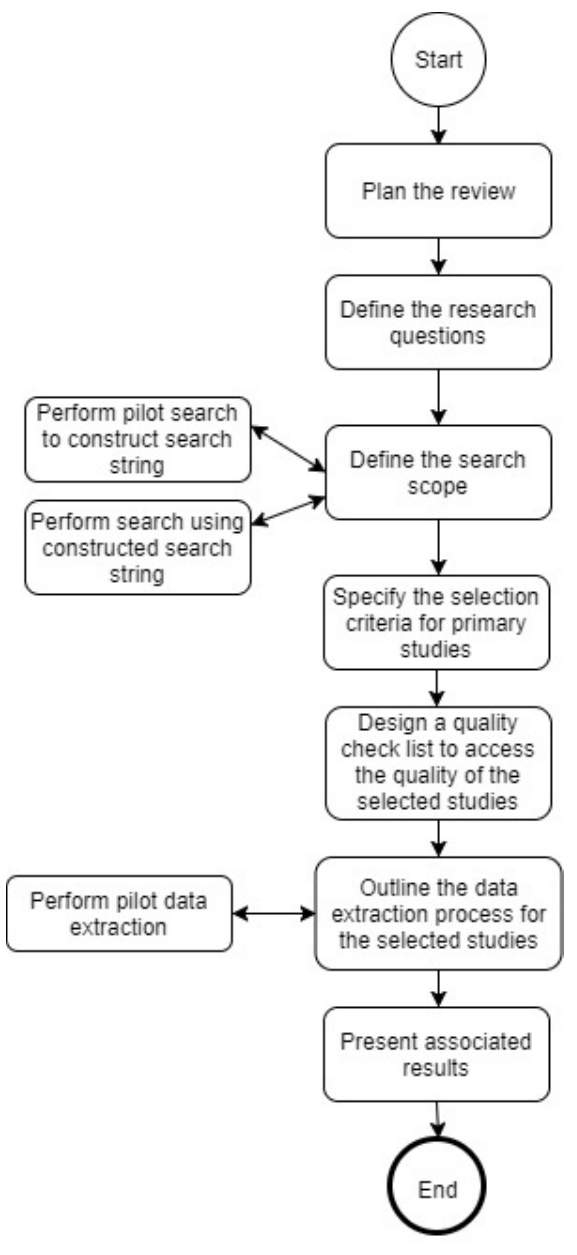
Figure 3. Systematic literature review protocol.